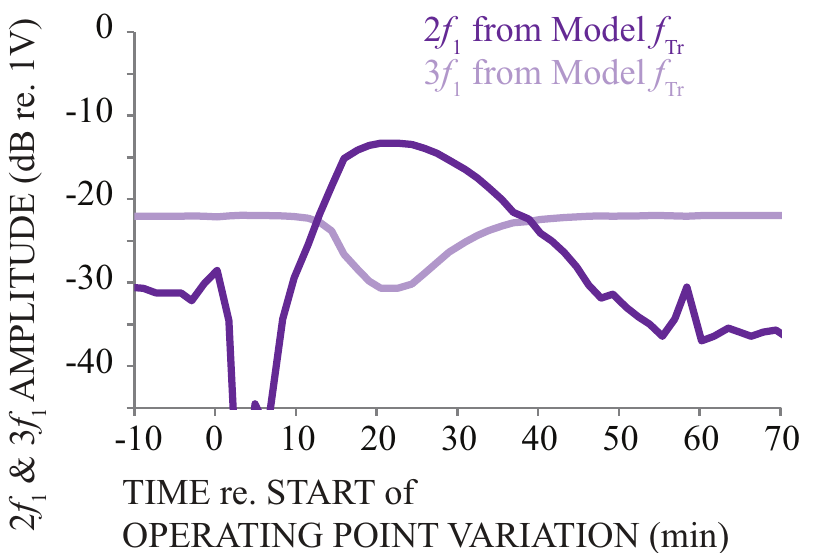
Fig 9. Simulated 2 f 1 and 3 f 1 harmonic distortion amplitude measurements from a Boltzmann analysis that used a sinewave input while OP was varied. OP estimates were obtainedfrom a previous simulation (i.e., the x-axis values of Fig 8D). The trends of simulated2 f 1 and 3 f 1 harmonics amplitudes expressedas a function of OP estimates are qualitatively similar to empiricalharmonic distortion amplitudemeasurements made duringapical injectionof 13 mM HP β CD (Fig 8A, shades of purple). This simulationsuggests that in vivo OP variations accountedfor essence of changesto empiricalharmonics measurements from 13 mM HP β CDtreatment. Together with the results from the previous Boltzmannanalysis(Fig 8B–8D), these results show that changesto the asymmetry, saturation, and sensitivity of in vivo f tr − and origin of distortion–can explaineffects of 13 mM HP β CDon DPOAE amplitudes (Fig 5,